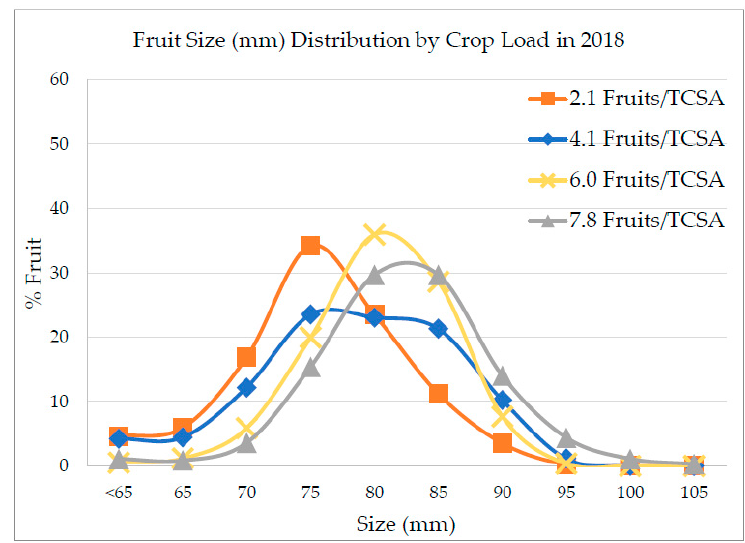
Figure 2. Distribution (% fruit) of fruit size (mm) by each crop load (2.1, 4.1, 6.0, 7.8 fruits/cm 2 ) level induced in 2017 at harvest for “WA38” apples grown in Washington State, Wenatchee area in 2018. Crop loads were manually induced in 2017, but the trees were left to bear naturally in 2018.